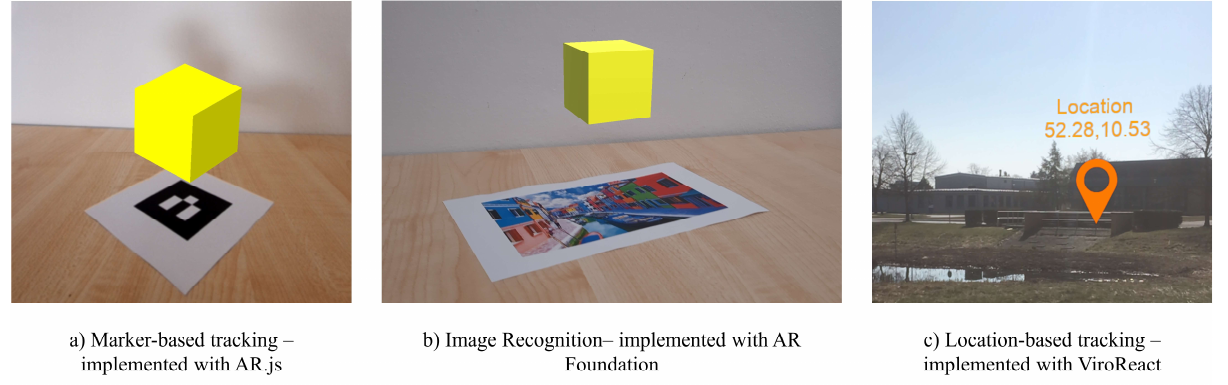
Figure 2. Examples of the results of the three different tracking